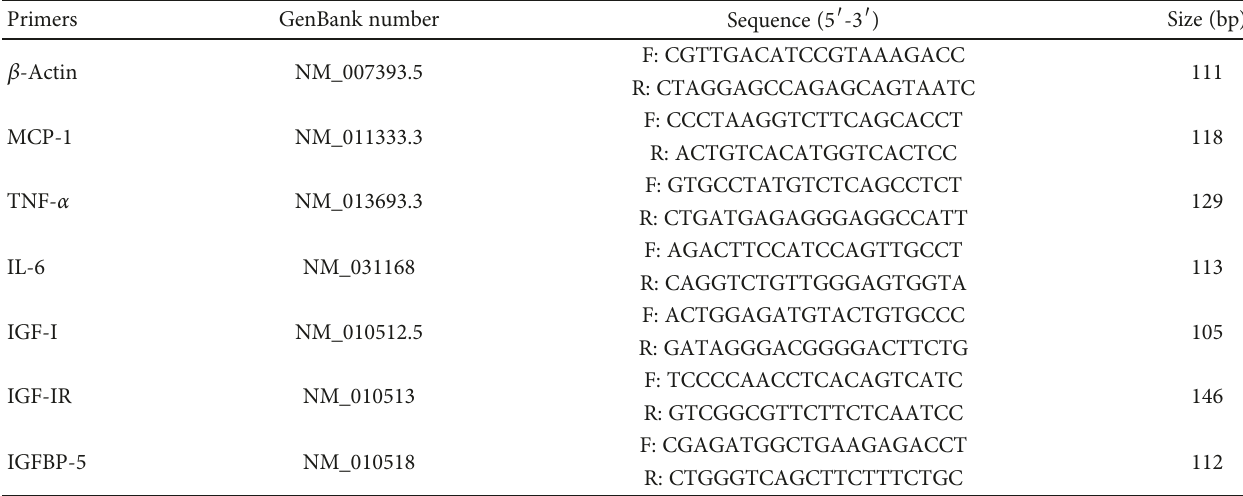
Table 1: Primers used for the quantitative real-time